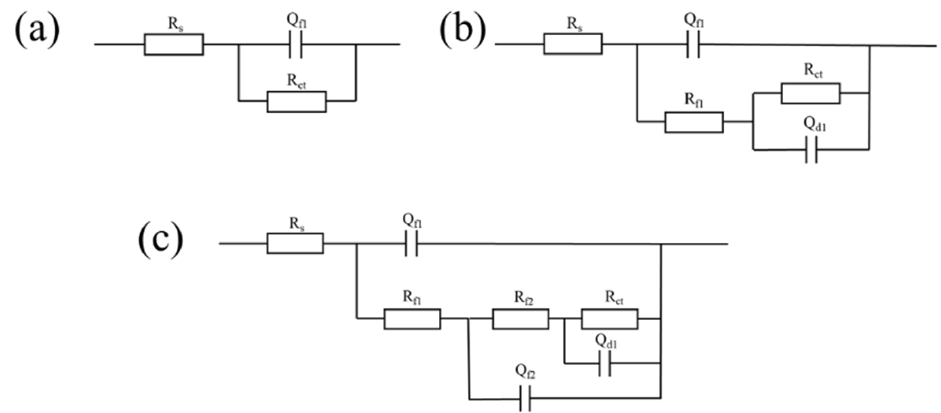
Figure 9. Equivalent circuit fitting diagrams of the ( a ) Blank, ( b ) CSA, and ( c ) CSA-LDH and CSA- LDH-PF samples. R S : solution resistance, R f : film resistance, Q f : capacitance of native oxidized film/passivated film, R ct : charge transfer resistance, Q dl : double layer capacitance. Table 6. Fitting results of the impedance spectroscopy in Figure